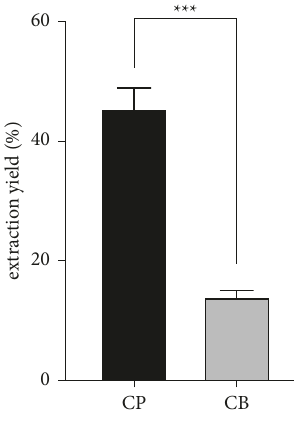
Figure 2: Extraction yield of marine and bovine collagen. CP: fish collagen; BC: bovine collagen. The values given represent the means ( standard deviation of the mean (SEM)) of three experiments ( n 3). The statistical significance of the results was assessed by the (cid:30) p t -Student test. 0 , 001 (significant differences from bovine ± ∗∗∗ <